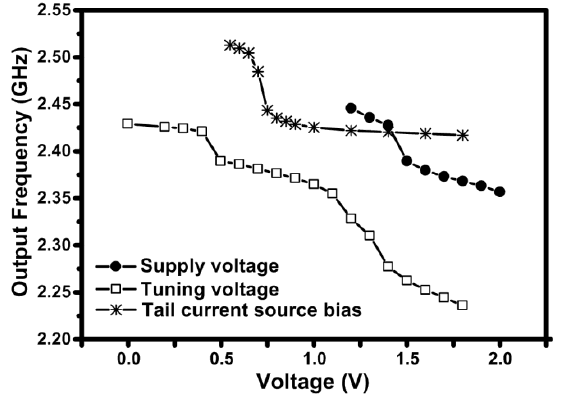
Figure 10. Measured frequency of oscillation of the 2.4 GHz design as a function the tail current source bias, supply voltage and tuning voltage. During the sweep of one bias voltage, the other two were kept constant at 1.5 V, except for the tuning voltage, which was kept constant at 0.5 V.